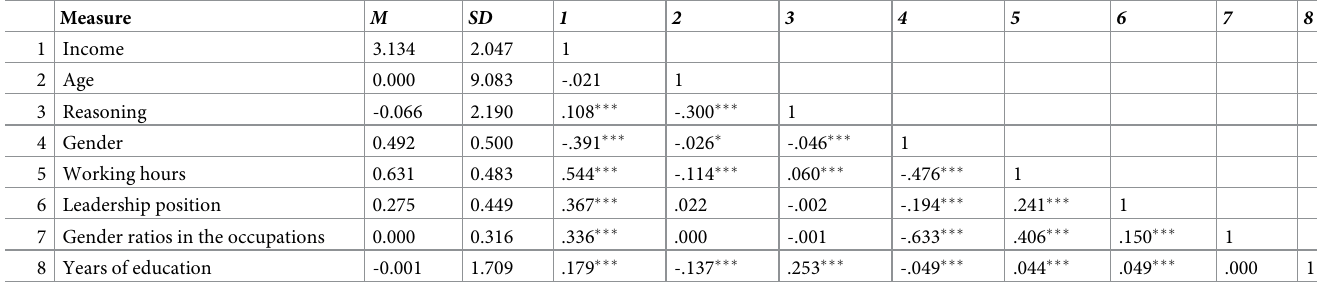
Table 1. Summary of zero-order correlations, means, and standard deviations (n = 6,070). Measure M SD